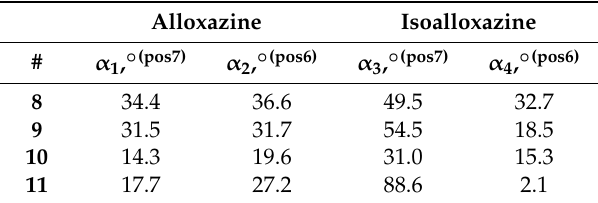
Table 2. Dihedral rotation angle between the alloxazine/isoalloxazine core and the aromatic rings. Alloxazine